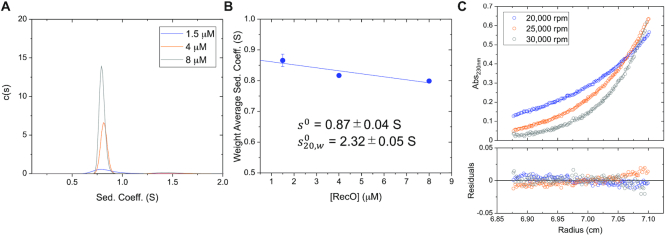

E. coli RecO is monomeric. (A) Sedimentation velocity c(s) distribution profiles of RecO (monitored at 230 nm) at 1.5, 4 and 8 μM in buffer BTP (pH 8.0) at 25°C. (B) The weight average sedimentation coefficient of RecO slightly decreases as a function of RecO concentration, expected for a pure, non-associating species (103–106). A linear extrapolation to zero RecO concentration yields s0 = 0.87 ± 0.04 S. From this we calculate \documentclass[12pt]{minimal}
\usepackage{amsmath}
\usepackage{wasysym}
\usepackage{amsfonts}
\usepackage{amssymb}
\usepackage{amsbsy}
\usepackage{upgreek}
\usepackage{mathrsfs}
\setlength{\oddsidemargin}{-69pt}
\begin{document}
}{}$s_{20,w}^0$\end{document} = 2.32 ± 0.05 S, consistent with a RecO monomer. (C) Results of sedimentation equilibrium experiments (monitored at 230 nm) performed at 4 μM RecO at three rotor speeds 20,000 (blue), 25 000 (orange) and 30 000 (gray) rpm are shown in blue, orange and gray. Each equilibrium profile is described by a single exponential. The solid lines show the best global NLLS fit of the three data sets to one-species model with mass constraints (Equation (2)) (99) yields a molecular weight estimate of 25.3 ± 0.3 kDa, consistent with the predicted molecular weight of 27.4 kDa for a RecO monomer. The bottom panel shows the residuals, indicating good fits.